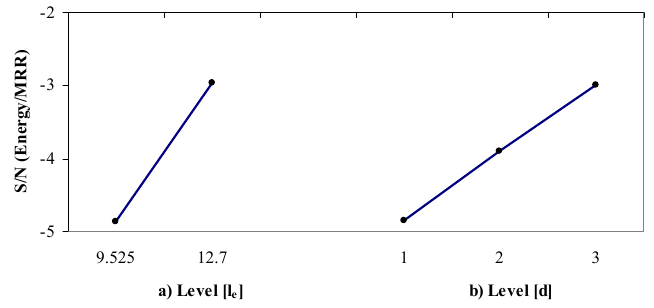
Figure 2. Values of the S/N ratios of significant main factors for energy/MRR.